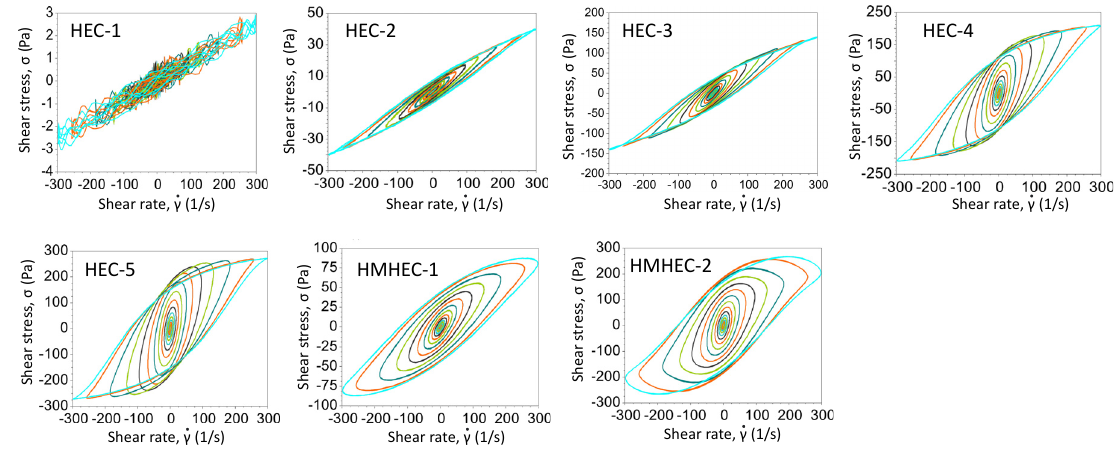
Figure 6. Lissajous–Bowditch curves for HEC-1, HEC-2, HEC-3, HEC-4, HEC-5, HMHEC-1, and HMHEC-2.